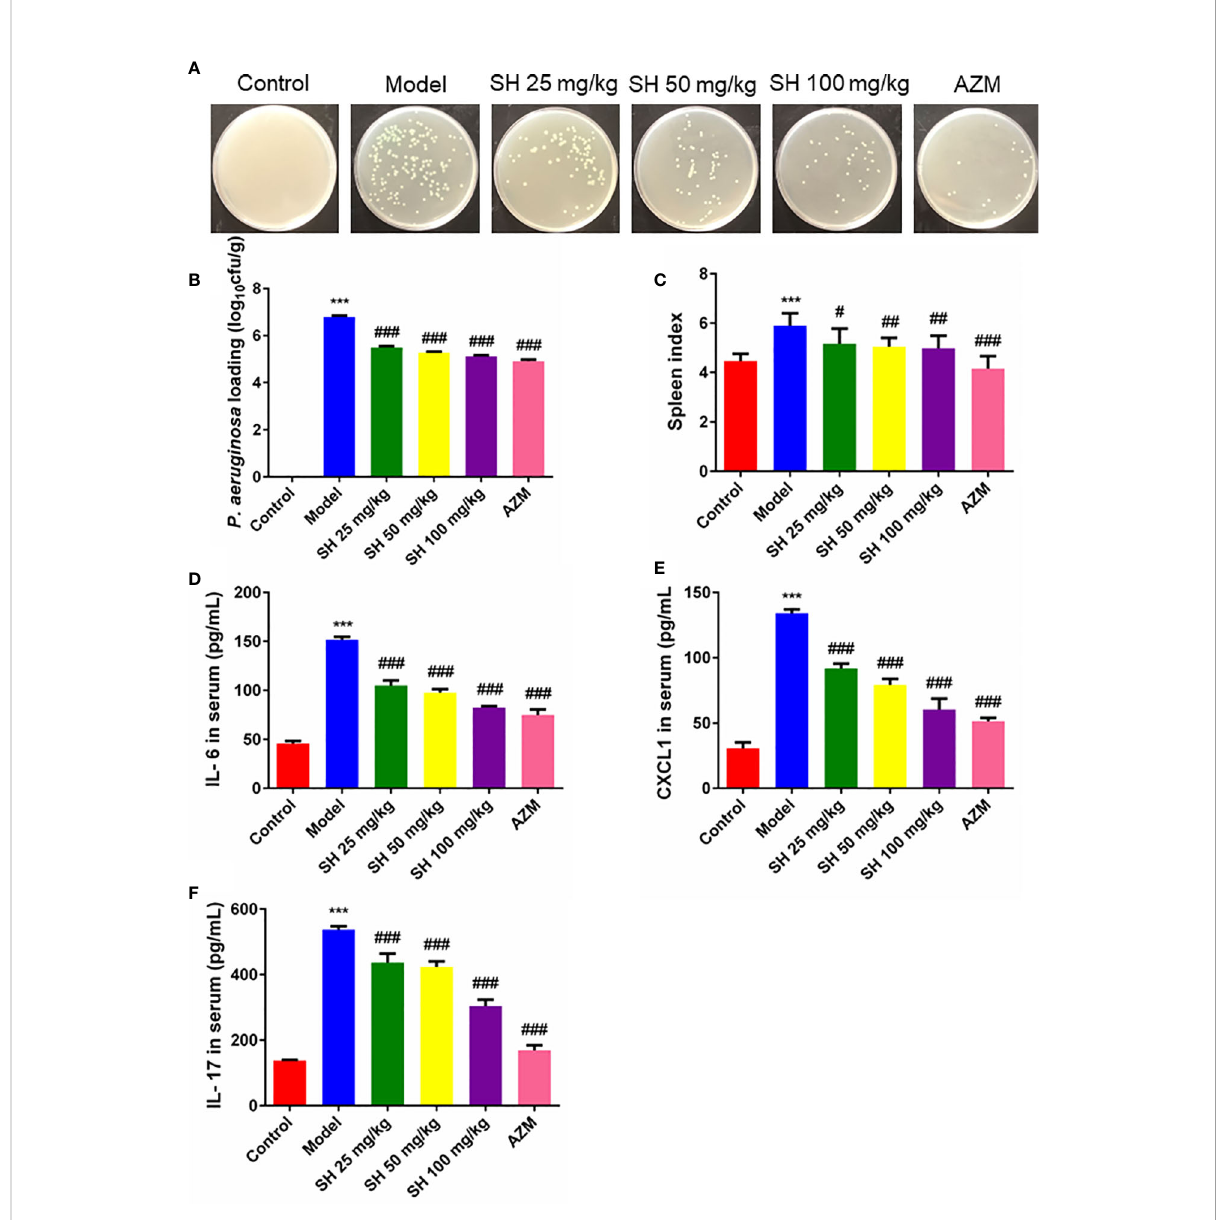
FIGURE 2 SH reduces P. aeruginosa burden and systemic in fl ammation in pneumonia mice. (A) The homogenized culture of mice lung tissue at different treatment after P. aeruginosa infection. (B) The number of viable P. aeruginosa isolated from the lung of mice. (C) Spleen index. (D) Serum IL-6, (E) CXCL1 and (F) IL-17 amounts were assessed by ELISA. Data are represented as mean ± SD (n=9). ***P<0.001 mean signi fi cance of model group compared with control group. # P<0.05, ## P<0.01 and ### P<0.001 mean signi fi cance of drug treatments compared with the model